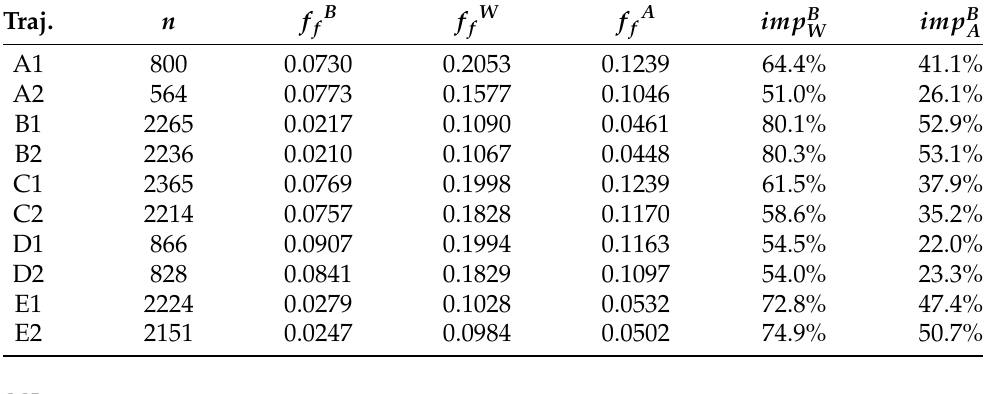
(9) and the average imp B location (10). W A